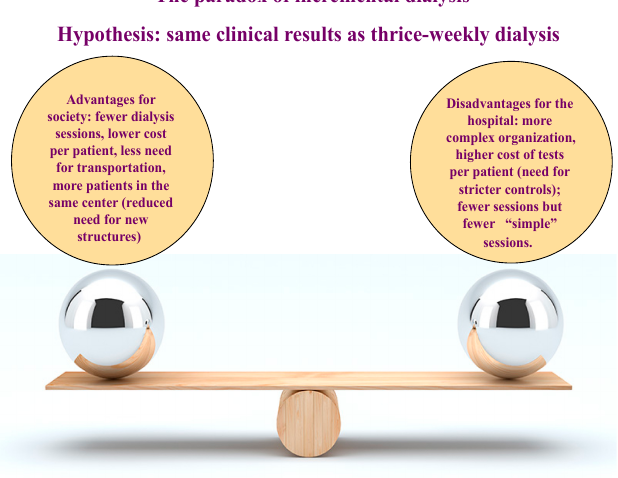
Figure 5. Paradoxes in care. The example of incremental dialysis. What is advantageous for the patient and for the society is not necessarily advantageous for the hospital.